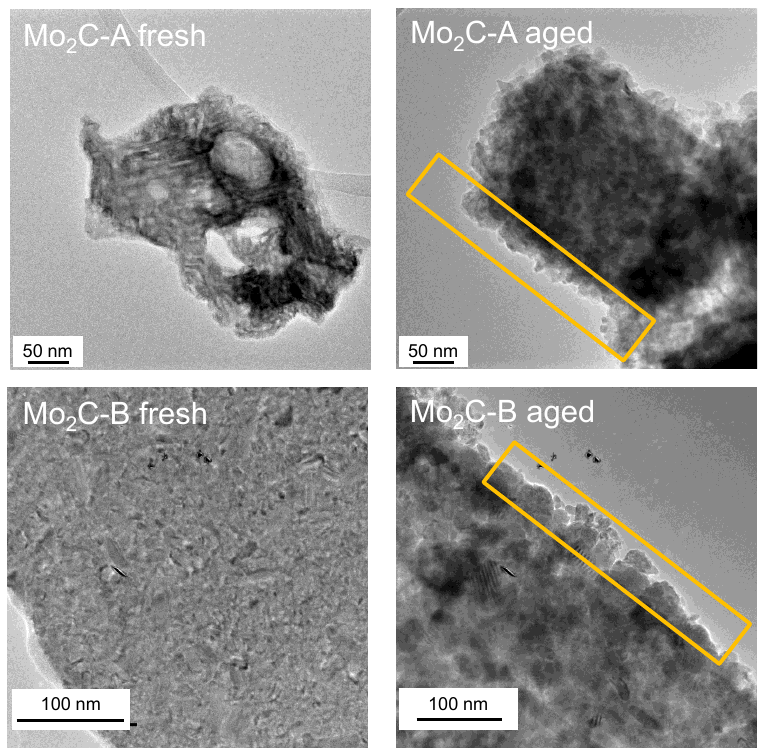
Figure 5. TEM images of Mo carbides in the fresh state and after 48 h aging at 250 °C in liquid water; the yellow boxes highlight increased surface roughness due to the formation of elliptically shaped